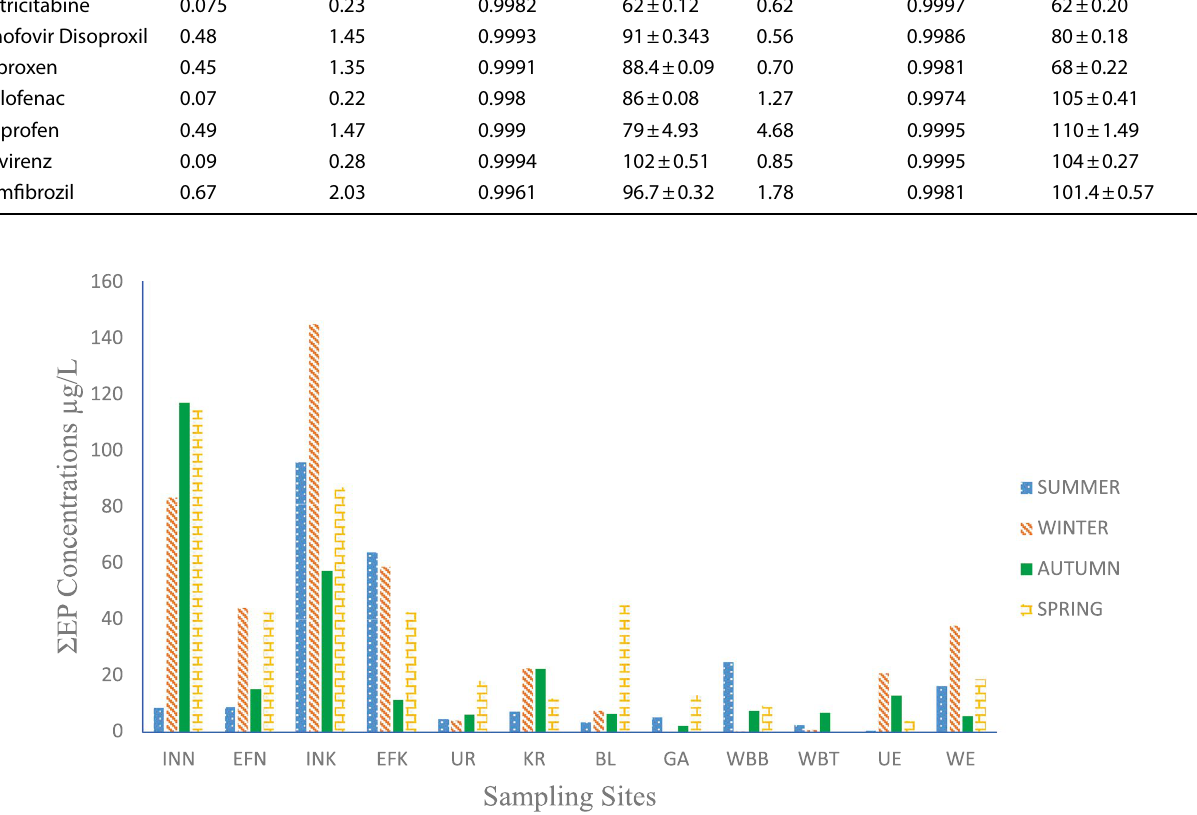
Fig. 5 Seasonal variation and Ʃ EP concentrations in µg/L around Durban aquatic